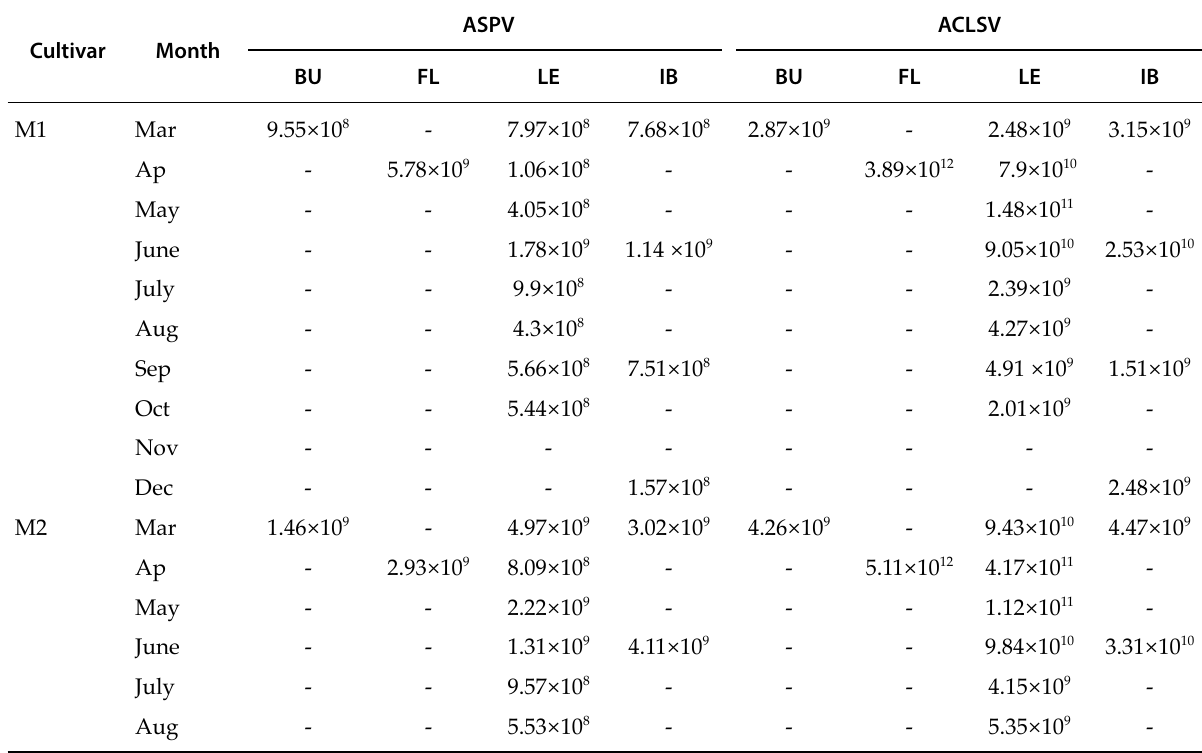
Table 3. List of absolute quantification of genomic RNA copies, obtained in RT-qPCR with an external standard curve, from different plant tissues of four apple cultivars (during ten months in 2015), infected with Apple stem pitting virus and Apple chlorotic leaf spot virus in